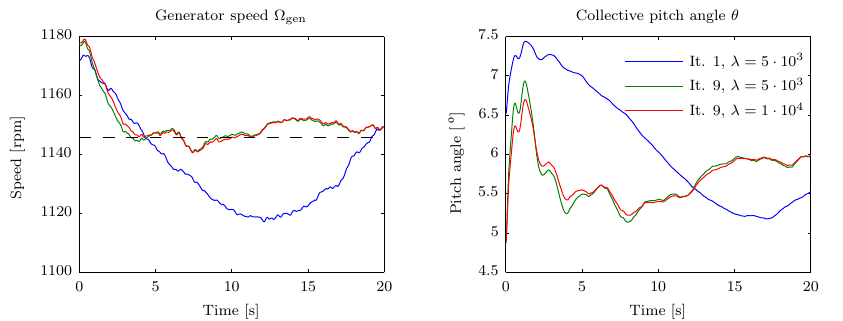
Figure 15. Comparison of the generator speed step response during the first and ninth iterations, and for different input weighting factors λ . Results shown are obtained for a wind speed of 14ms − 1 with 4% turbulence